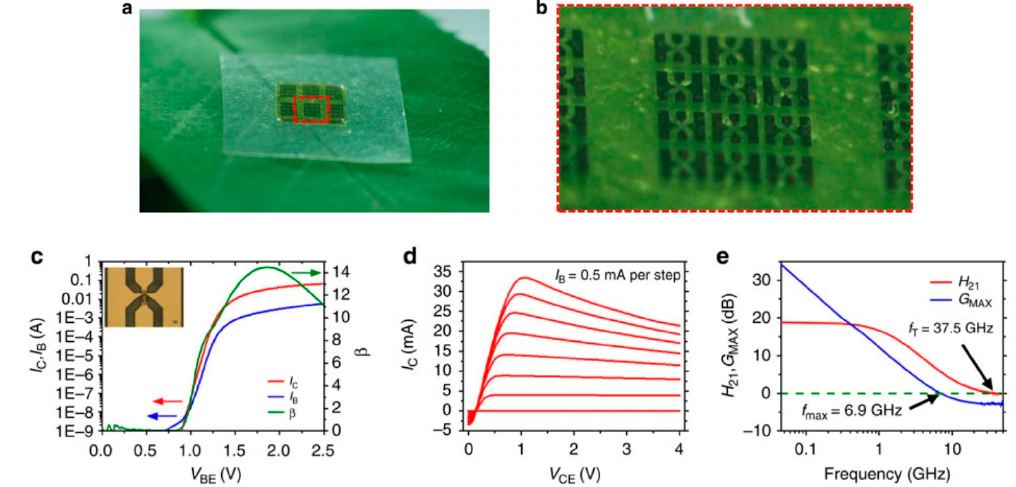
Figure 2. ( a ) Photograph of an array of heterojunction bipolar transistors (HBTs) on a transparent cellulose nanofibril (CNF) substrate; ( b ) Zoom on the array. ( c ) Collector and base currents showing the maximum gain of the device. ( d ) Collector current versus collector–emittor for various base current. ( e ) Gains (H for current, G for power) as a function of frequency, with a collector voltage of 2 V